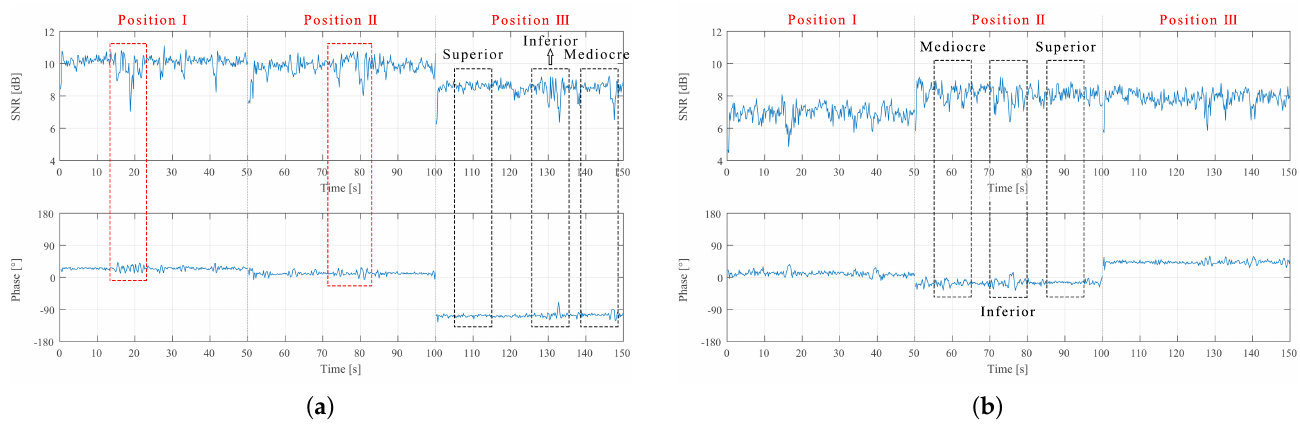
Figure 12. SNR and extracted phase results of three positions. ( a ) C01 ( b ) C04.